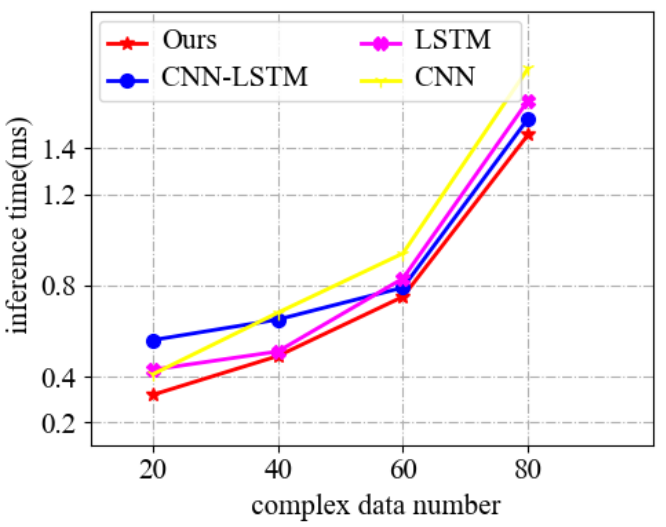
Figure 15. Inference time comparison of different